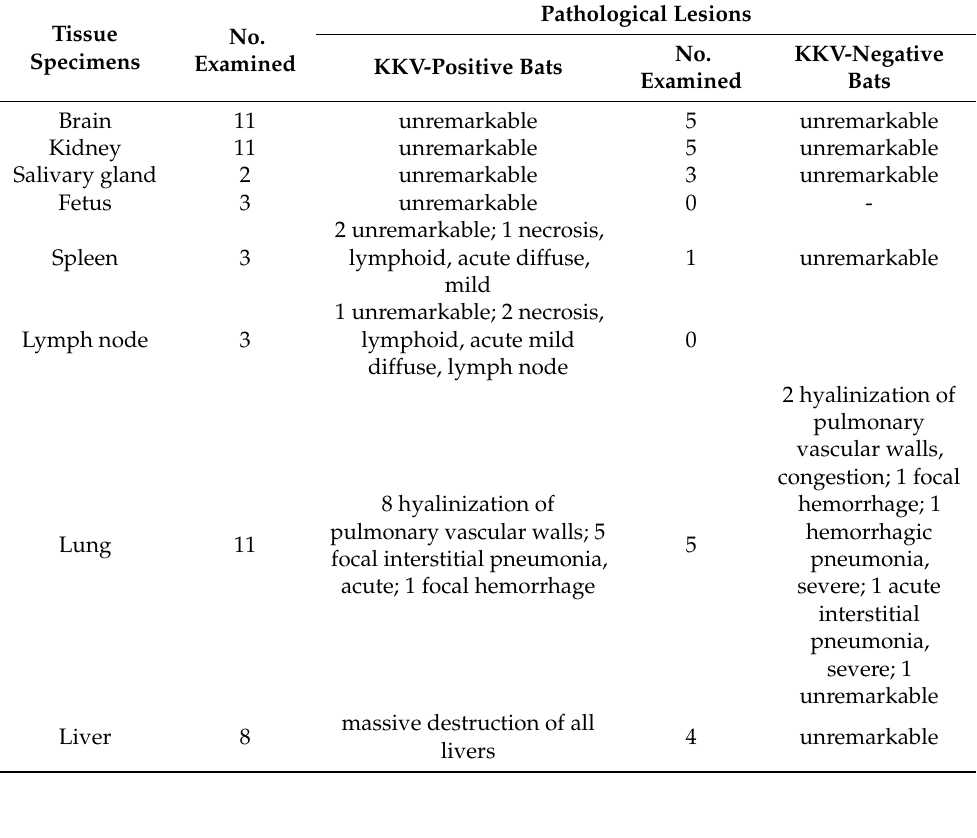
Table 8. Pathological lesions in tissues of virus-positive and virus-negative morbid bats.